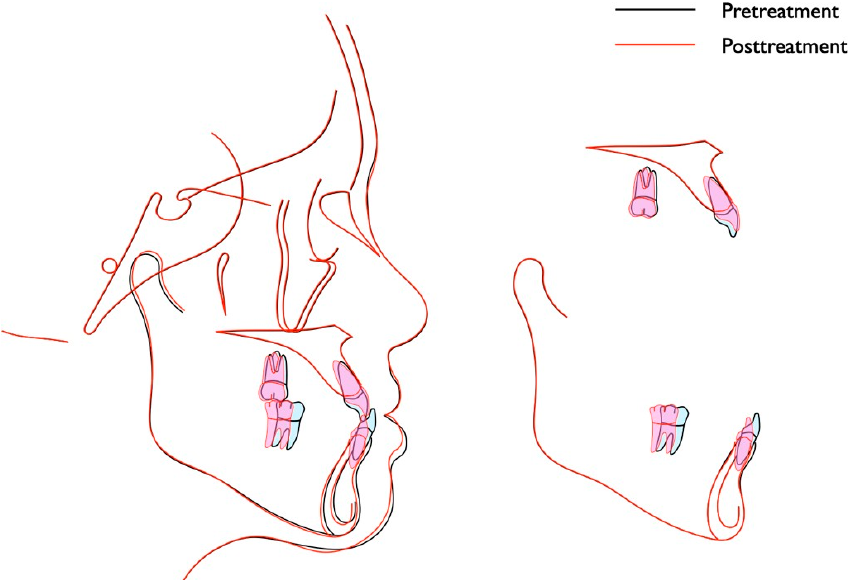
Figure 15. Case 2, Cephalometric superimpositions show the correction of anterior crossbite and Class III malocclusion with a nonextraction approach supported with TSADs. Table 2. Case 2, cephalometric measurements.